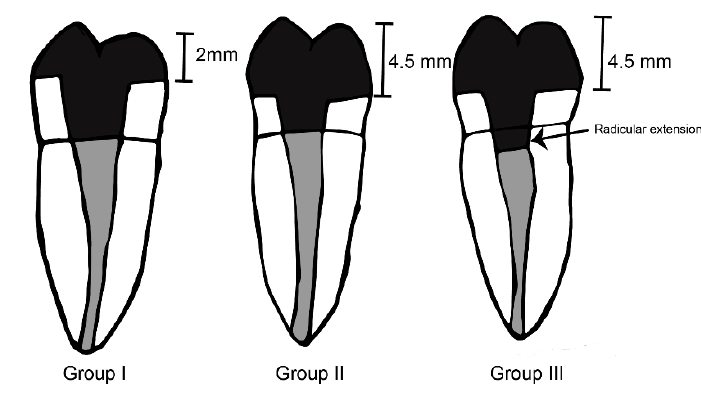
Figure 1. Endocrowns designs for different groups .